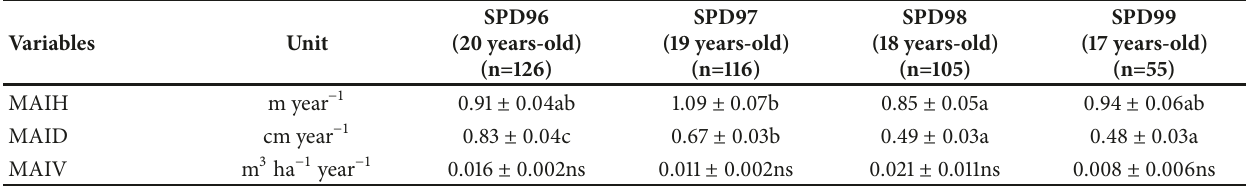
Table 2: Mean annual increments of height (MAIH), diameter at breast height (MAID), and volume (MAIV) of planted Shorea macrophylla in reforestation sites.